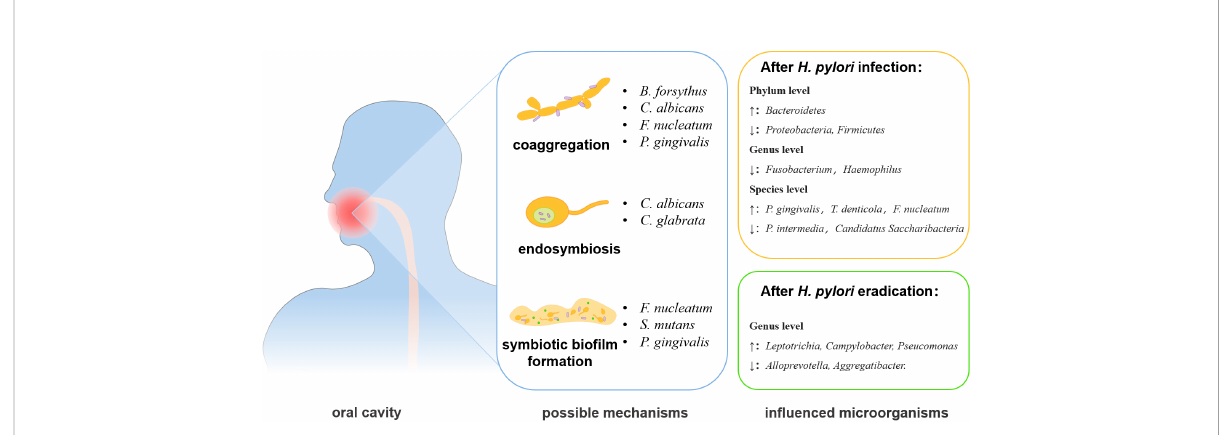
FIGURE 1 The changes and interactional mechanisms of H. pylori and oral microbiota. The interactions between H. pylori and oral microbiome may act through co-aggregation, endosymbiosis, and formation of symbiotic bio fi lm. The eradication of H. pylori infection can also affect the oral